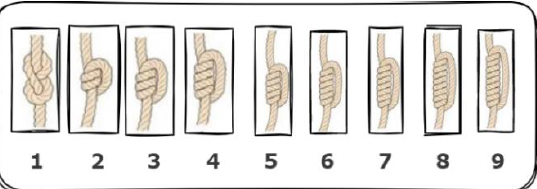
Figure 6. Sample nodes and related calculations where numbers are added as units and tens and hundreds (adopted from [22]).